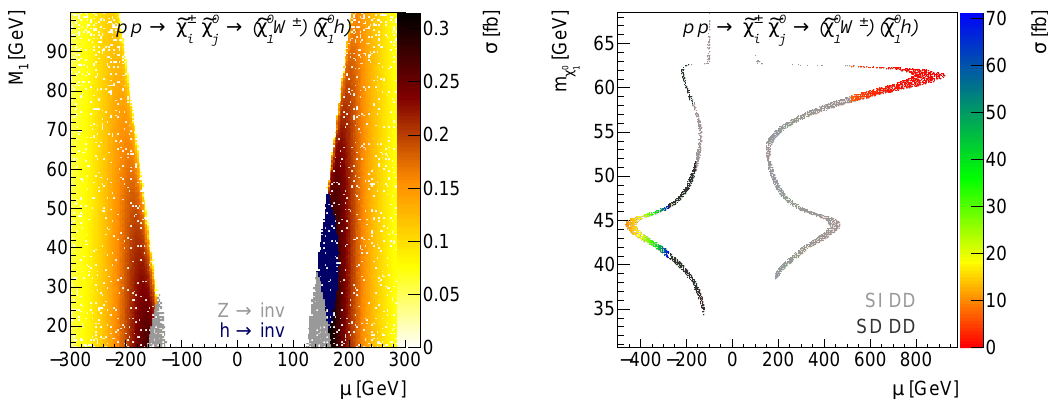
Figure 16: Cross section for the mono- Wh -pair process in the µ − M points fulfilling the chargino mass bound, shown with the limits on invisible Z and Higgs decays. Right: points also predicting the correct relic density, shown with DD